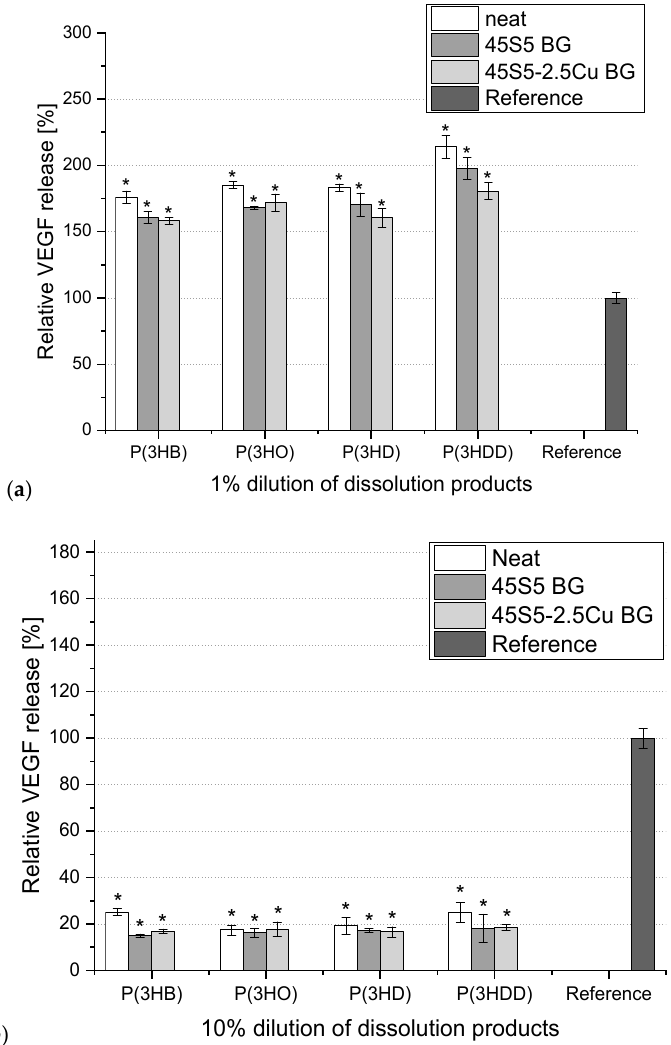
Figure 4. Relative vascular endothelial growth factor (VEGF) release from ST2 cells cultured in media containing 1% ( a ) and 10% ( b ) dilution of dissolution products of BG-PHA and neat PHA scaffolds. One-way ANOVA statistical analysis denotes significant difference (*p < 0.05) compared with the reference. As reference pure CCM was used (Bonferroni’s post hoc test was used).